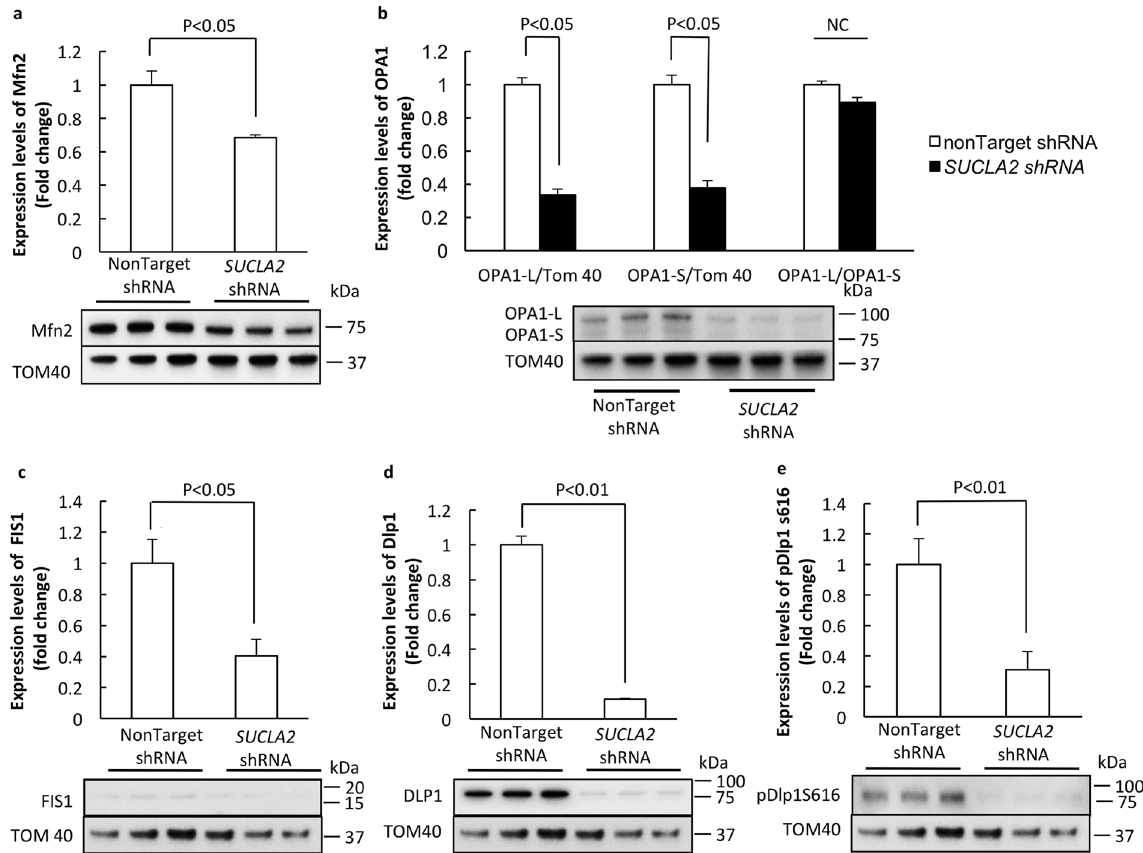
Figure 5. Loss of SCS A- β suppresses the expression of mitochondrial fusion and fission proteins. The expression levels of Mfn2 ( a ), OPA1 ( b ), FIS1 ( c ), Dlp1 ( d ) and pDlp1S616 ( e ) were measured by using immunoblotting. The lower panels are representative immunoblots. The data were collected from 3 independent